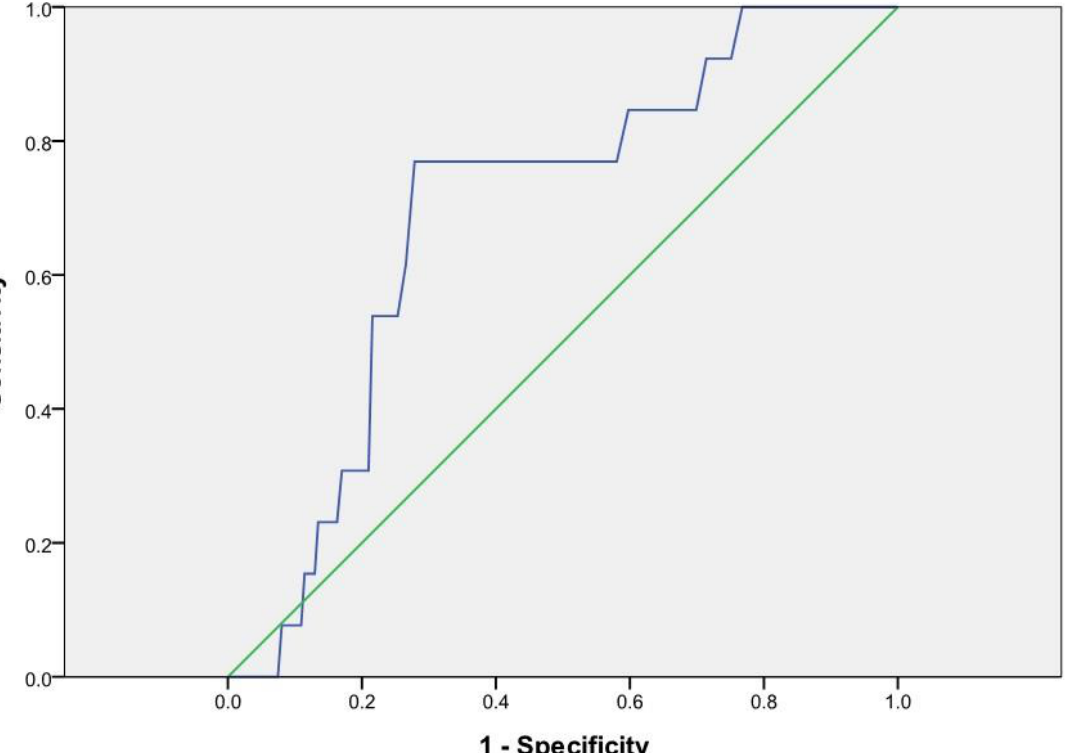
Figure 1. Combined receiver-operating characteristic curve of preoperative serum ALP levels for incidence of postoperative 30-day major adverse cardiac and cerebrovascular (MACCE). The area under the curve = 0.694 and p -value = 0.016 are observed below the line showing the serum ALP level with a 95% confidence interval of 0.574 – 0.813. The optimal cut-off value of serum ALP that predicted the incidence of MACCE was 83 IU/L, with a sensitivity and specificity of 76.9% and 72.1%, respectively. ALP; alkaline phosphatase, MACCE; major adverse cardiac and cerebrovascular events.